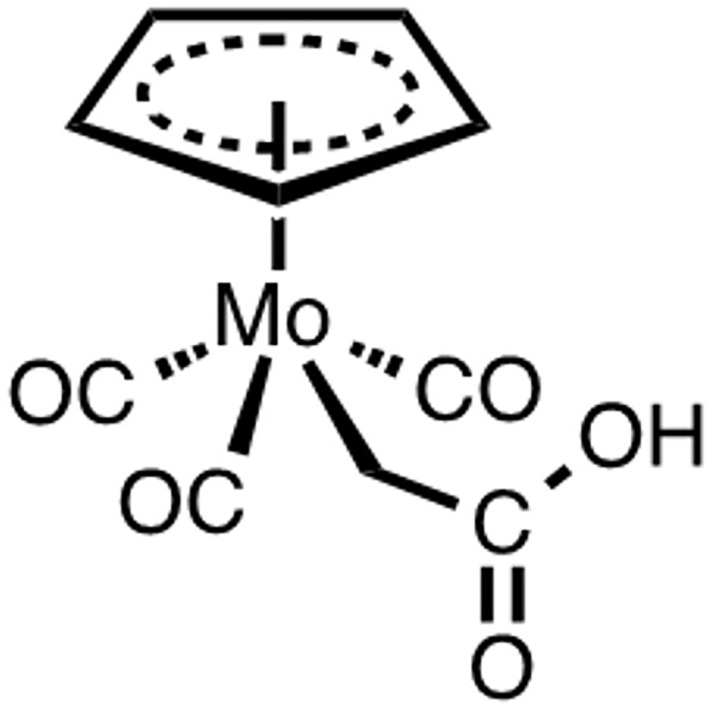
ALF414 structure.